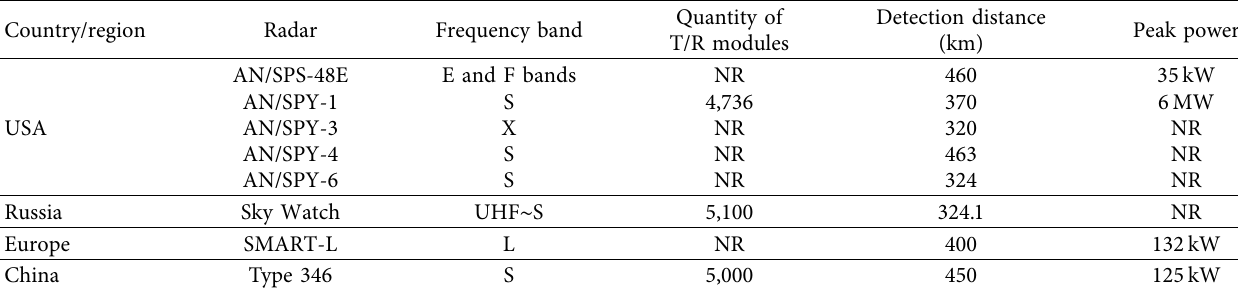
Table 2: Main parameters of diferent shipborne radar.